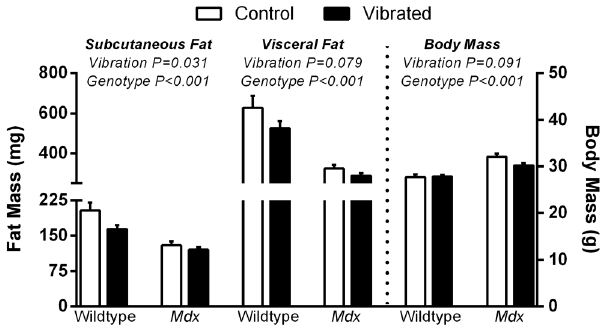
Figure 1. Eight weeks of vibration training affected fat pad masses but not body masses. Vibrated mice had smaller sized subcutaneous fat pads following 8-weeks of training. Mdx mice had a larger body mass but smaller fat pad masses compared to wildtype mice following 8-weeks of training. Body masses were not different in mice subject to vibration compared to non-vibrated control mice. Data are means 6 SE. P-values associated with the main effects of two-way ANOVAs are indicated above each set of bars. Interactions between vibration and genotype P $ 0.056.